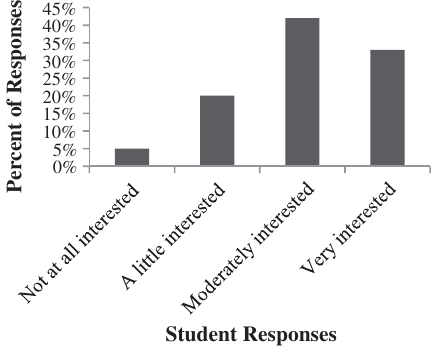
FIG. 3. Self-reported interest in science.